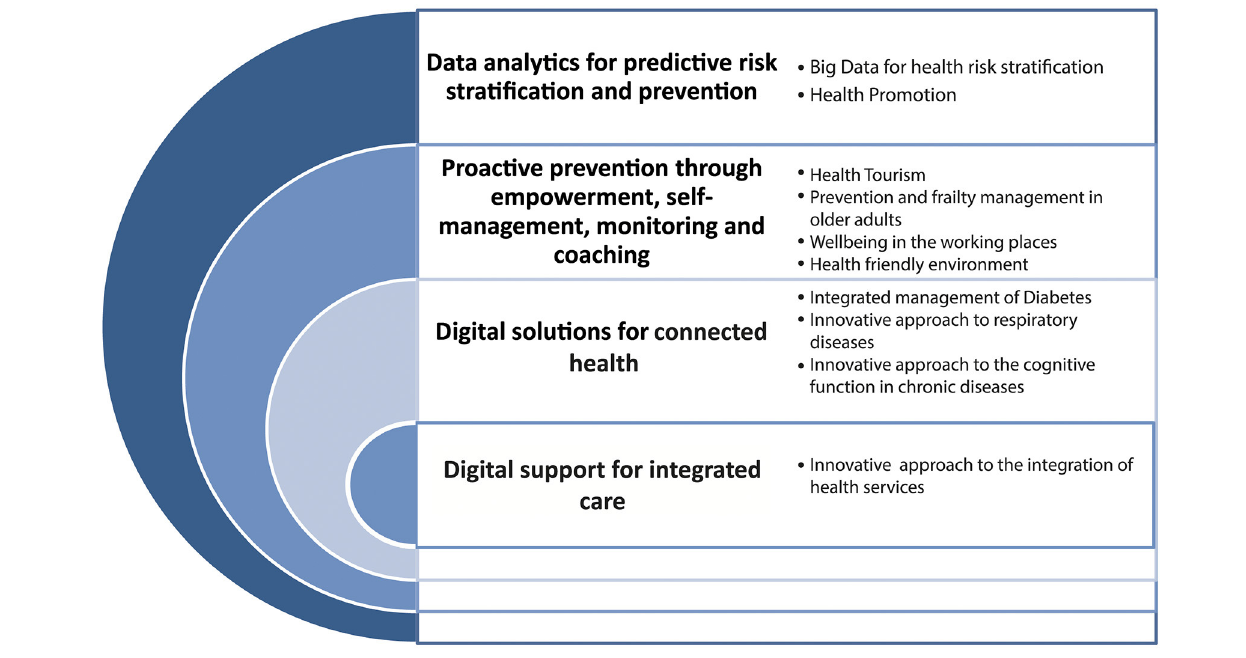
with the four priorities of the European Blueprint for the digital transformation of health and care for the aging society (23,